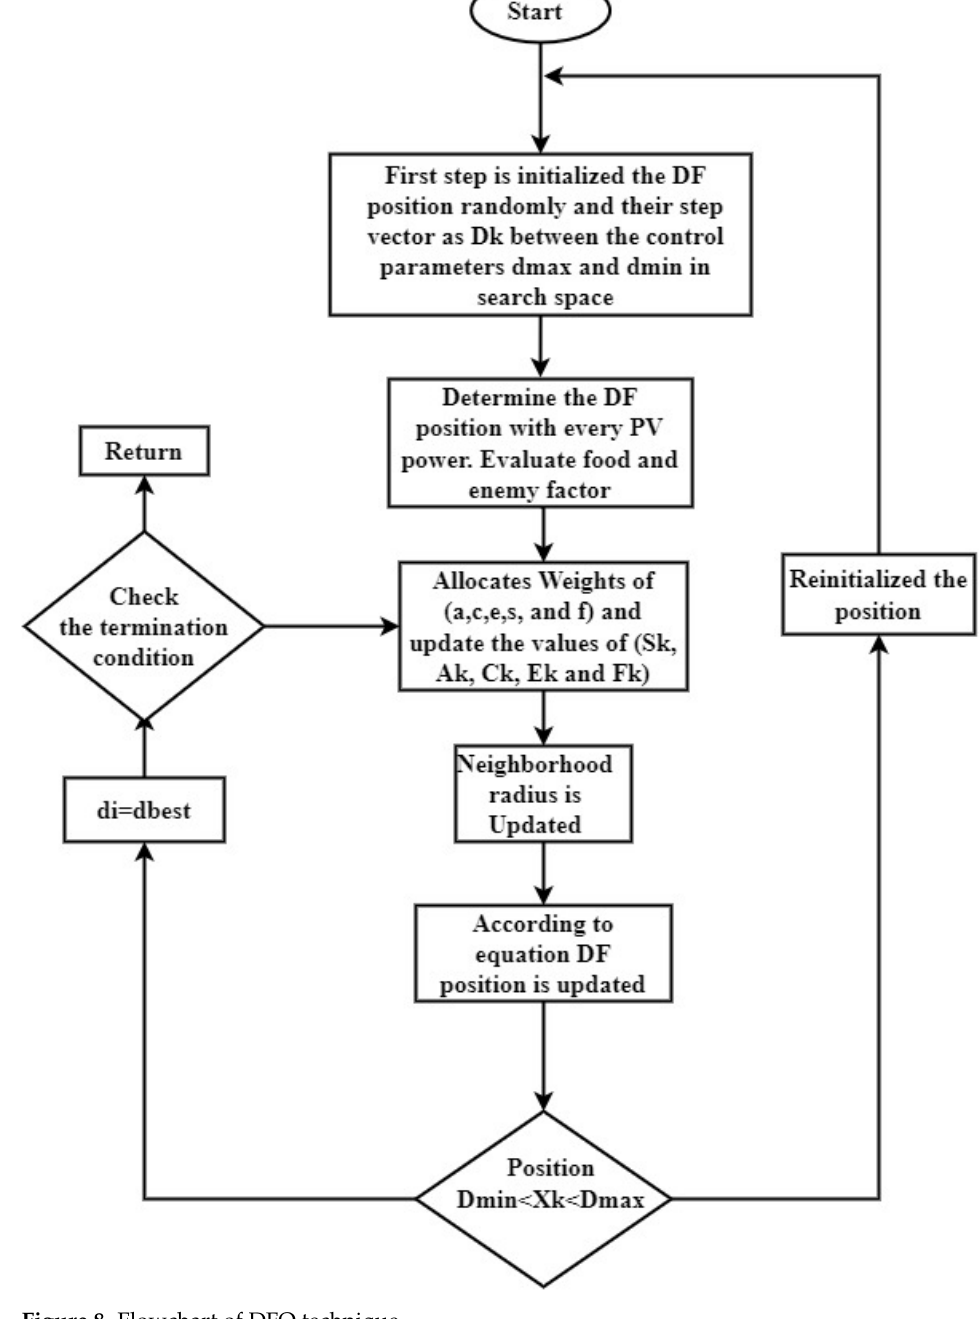
Figure 8. Flowchart of DFO